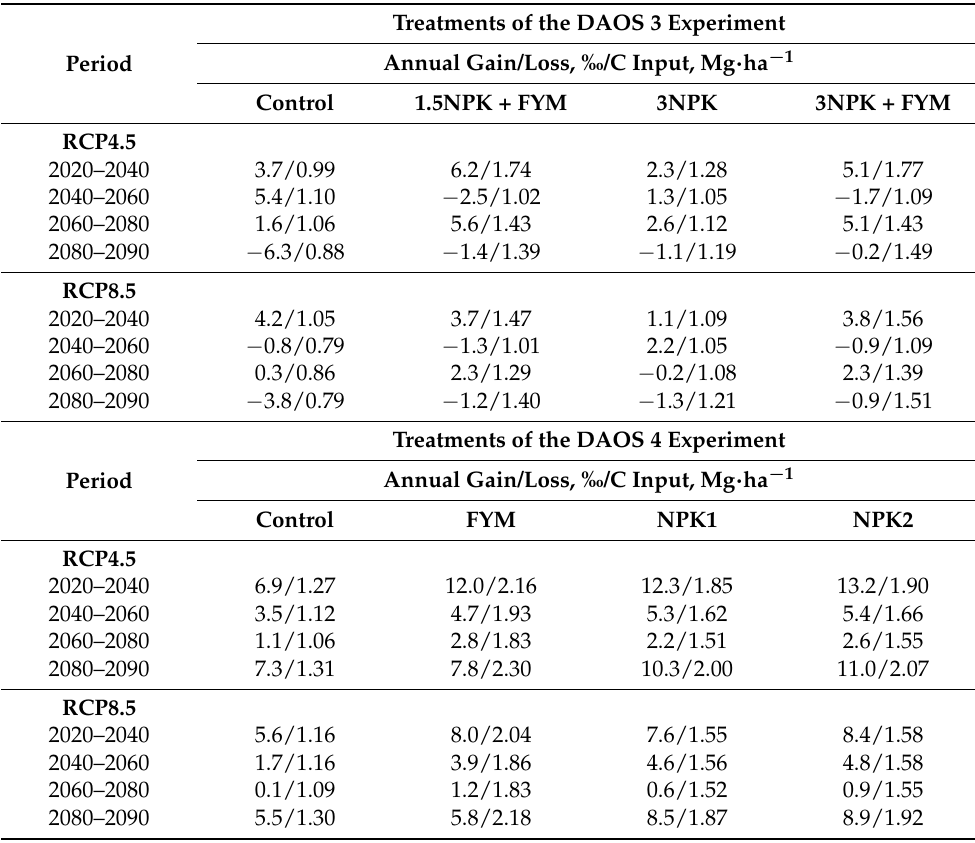
Table 2. Annual gain/loss and input of C by treatments. RCP: Representative Concentration